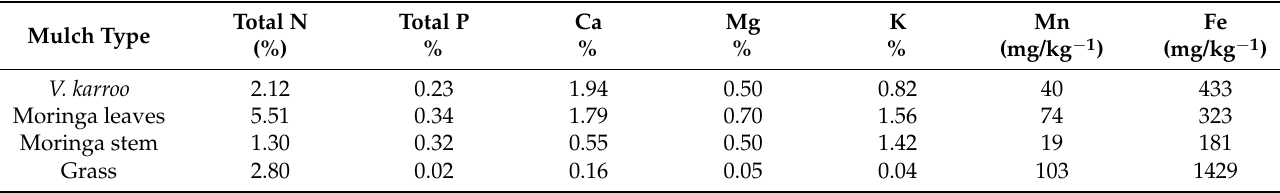
Table 3. Organic mulch material nutrient status.